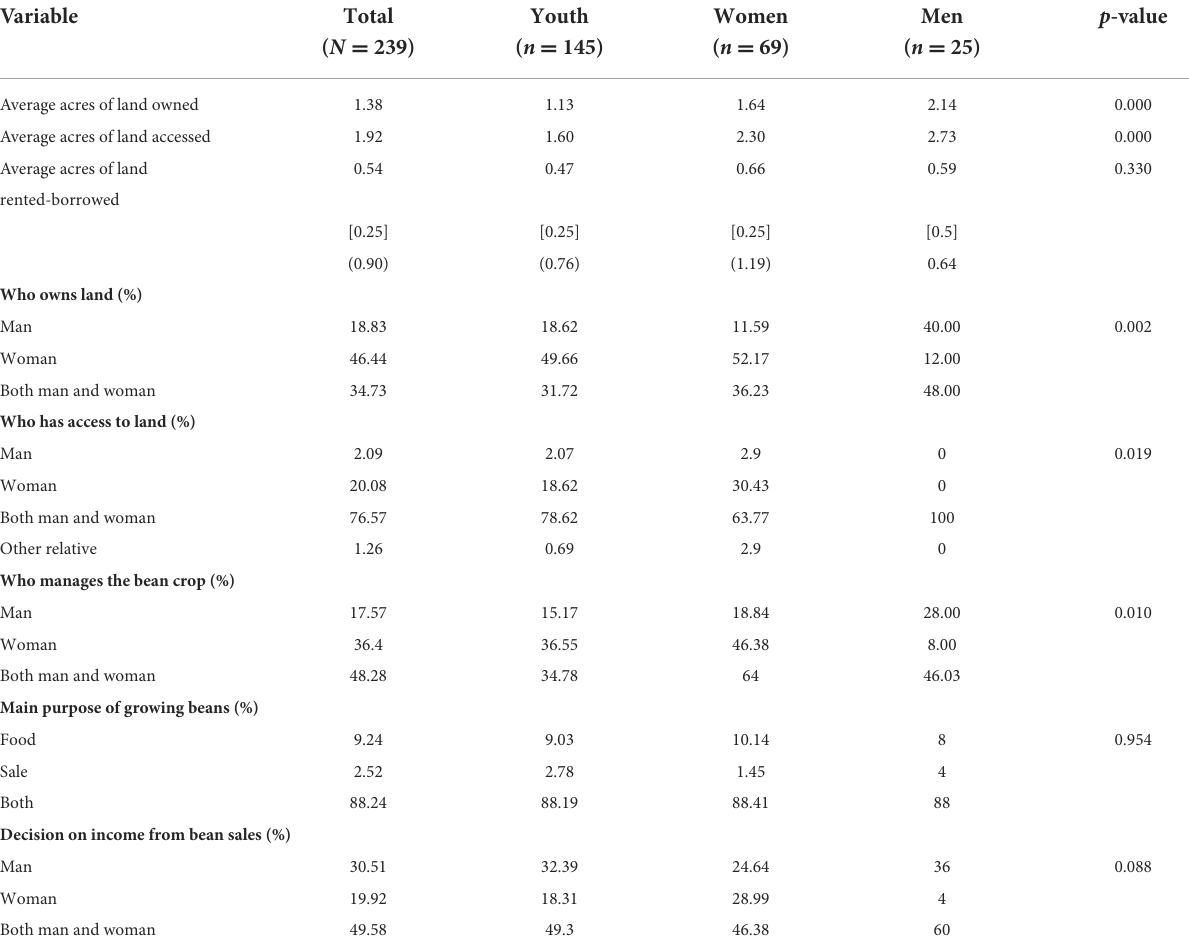
TABLE 2 Common bean farming